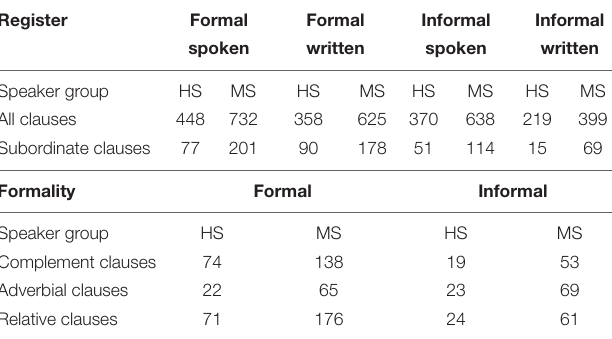
TABLE 2 | German clause productions by speaker group and